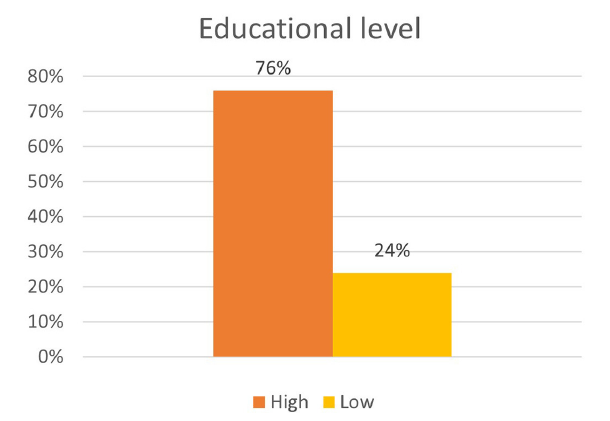
FIGURE 3 | Overview of distribution by educational